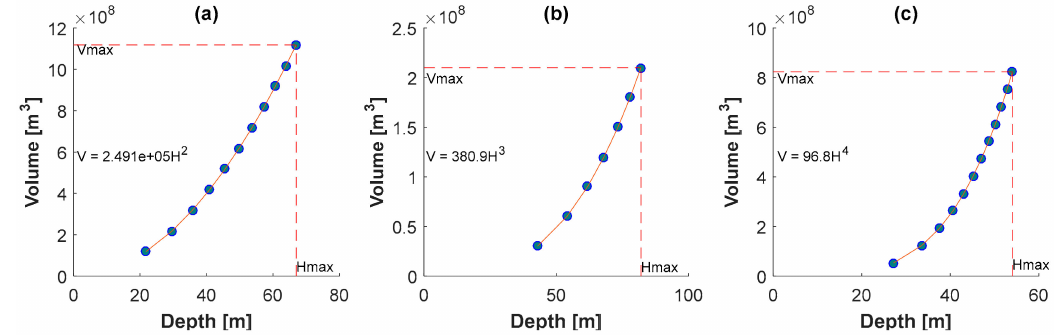
Figure 9. Volume–depth relationships for three studied reservoirs: ( a ) Alarcon; ( b ) Fuensanta; ( c ) La Brena.